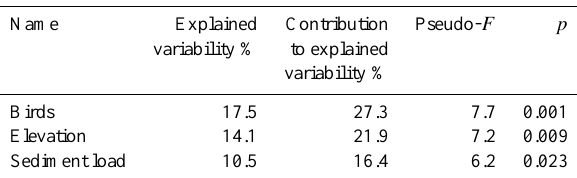
Table 7. Results for the partial RDA with glacier and place as covariables, after interactive forward-selection covariates analysis. Fourteen environmental (physical, morphological and chemical) variables are tested; only significant results are shown. Explained variability means proportion of variability explained by each vari- able in the total model (variability explained by all variables is 64.3% including non-significant ones). Contribution to explained variability means the proportion of a selected variable in variability explained by selected